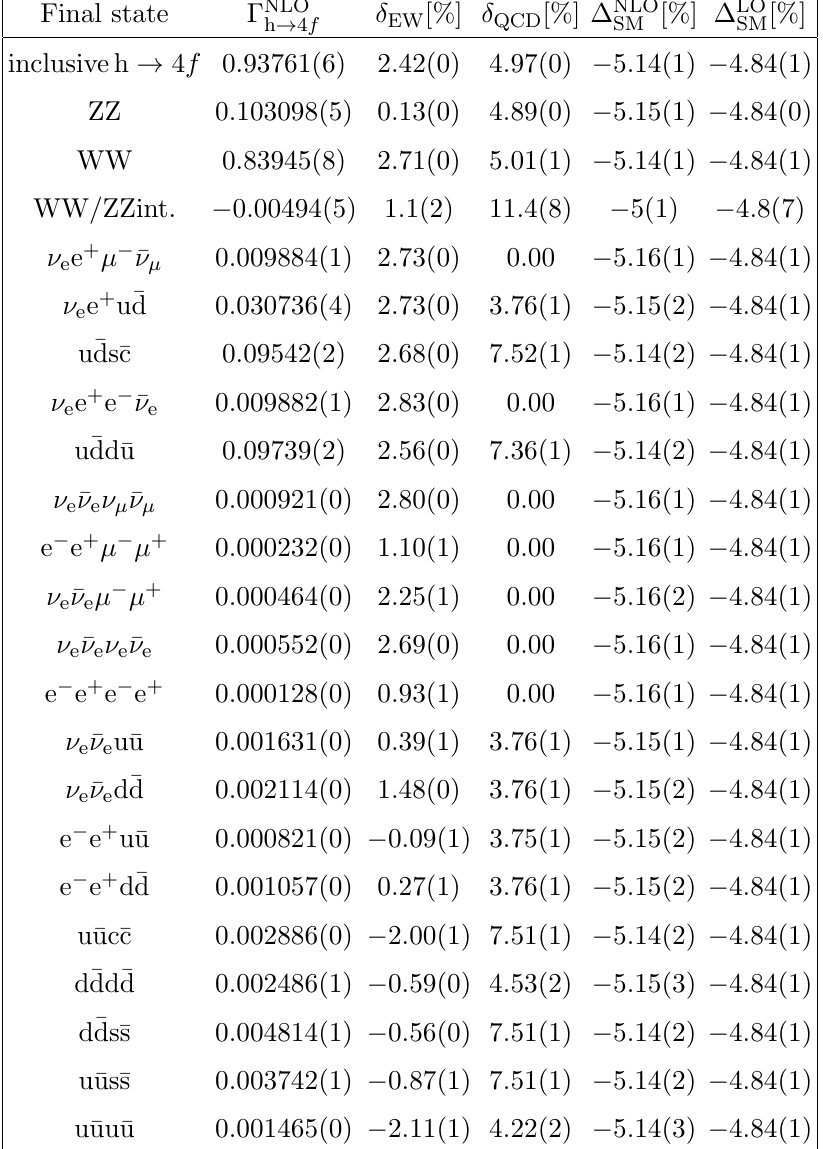
Table 4 . Partial widths for scenario BHM600 in the FJ renormalization scheme. The integration errors are given in